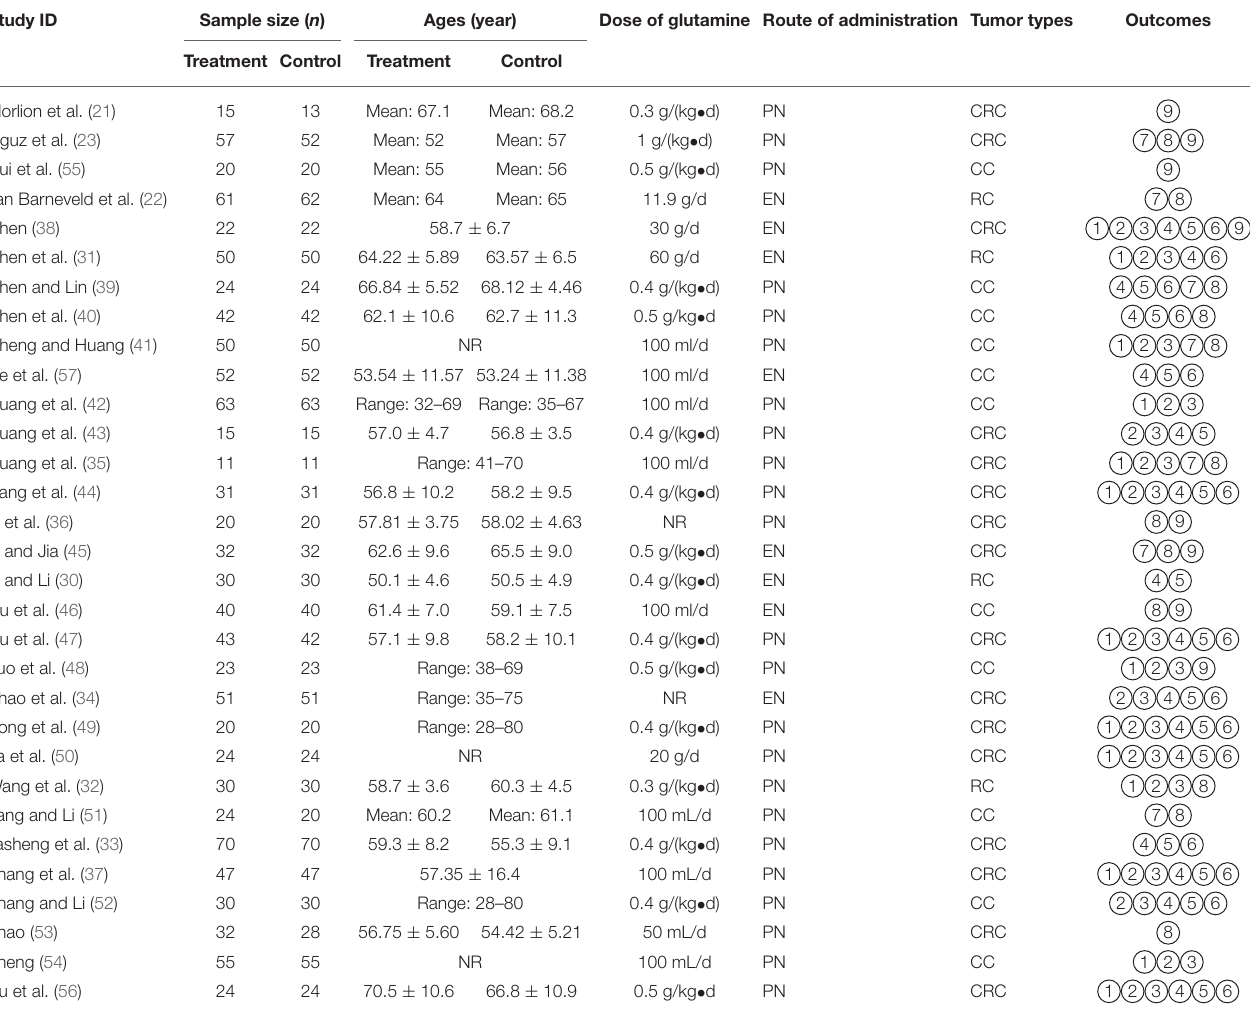
TABLE 1 | Main information of included studies in the